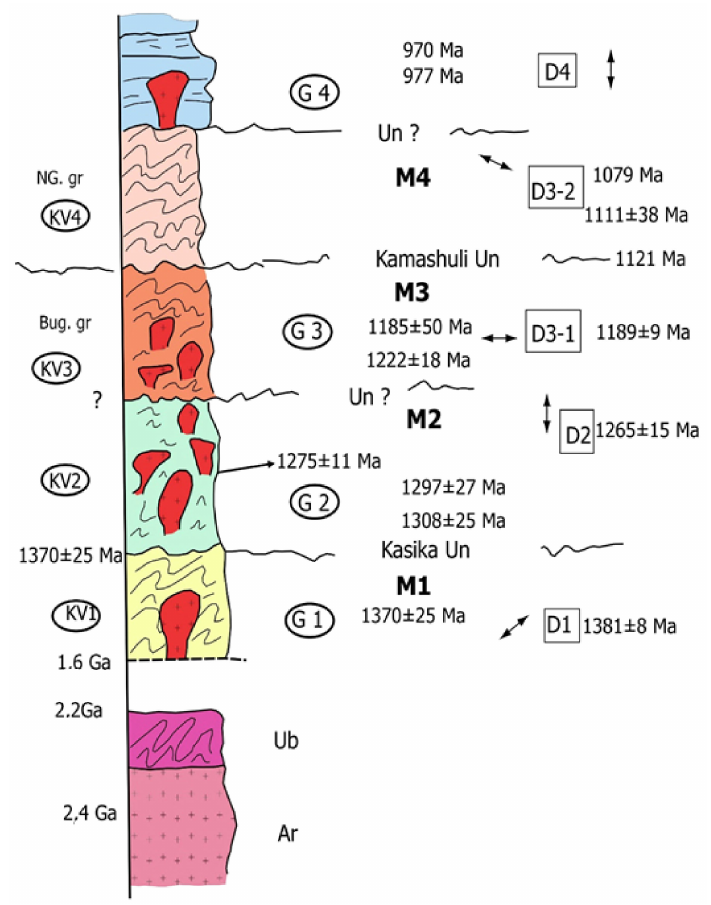
Figure 3. The main tectono-stratigraphic events in the Kivu Belt (KVB). KV1, KV2, KV3, and KV4– main Kibaran formations in the Kivu Belt, M1 to M4-main metamorphic events, D1 to D4-main tectonic events. Ages are given in million